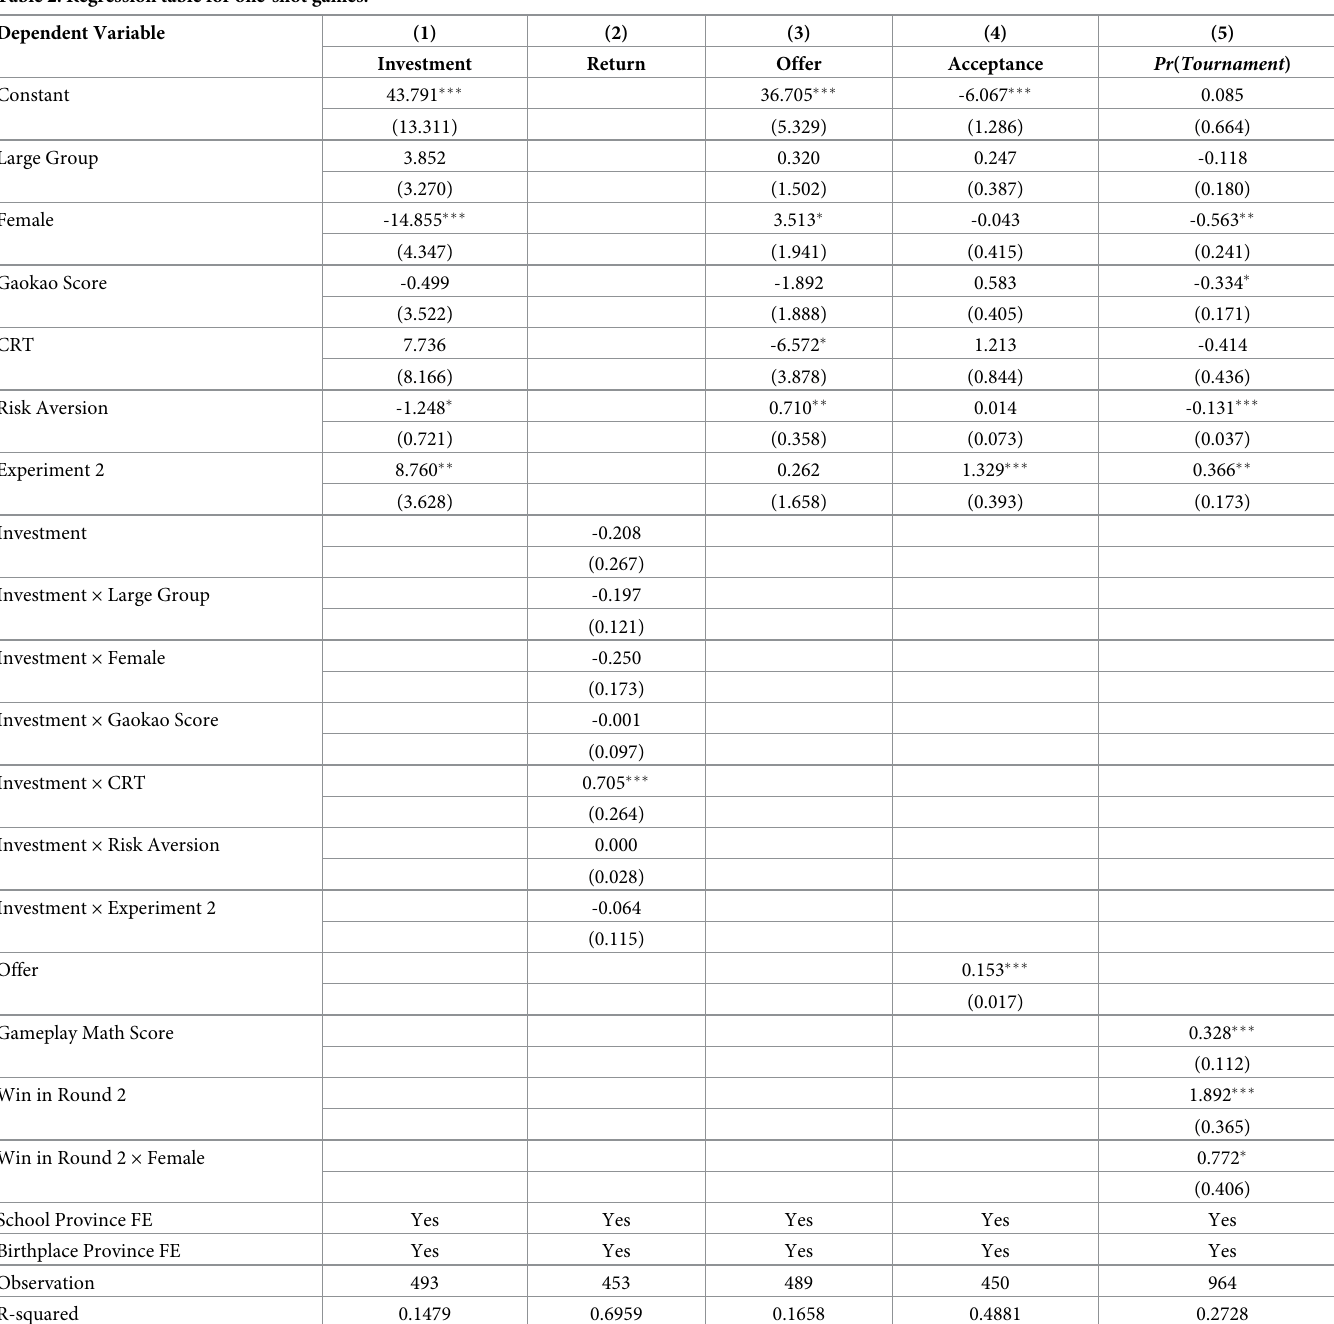
Table 2. Regression table for one-shot